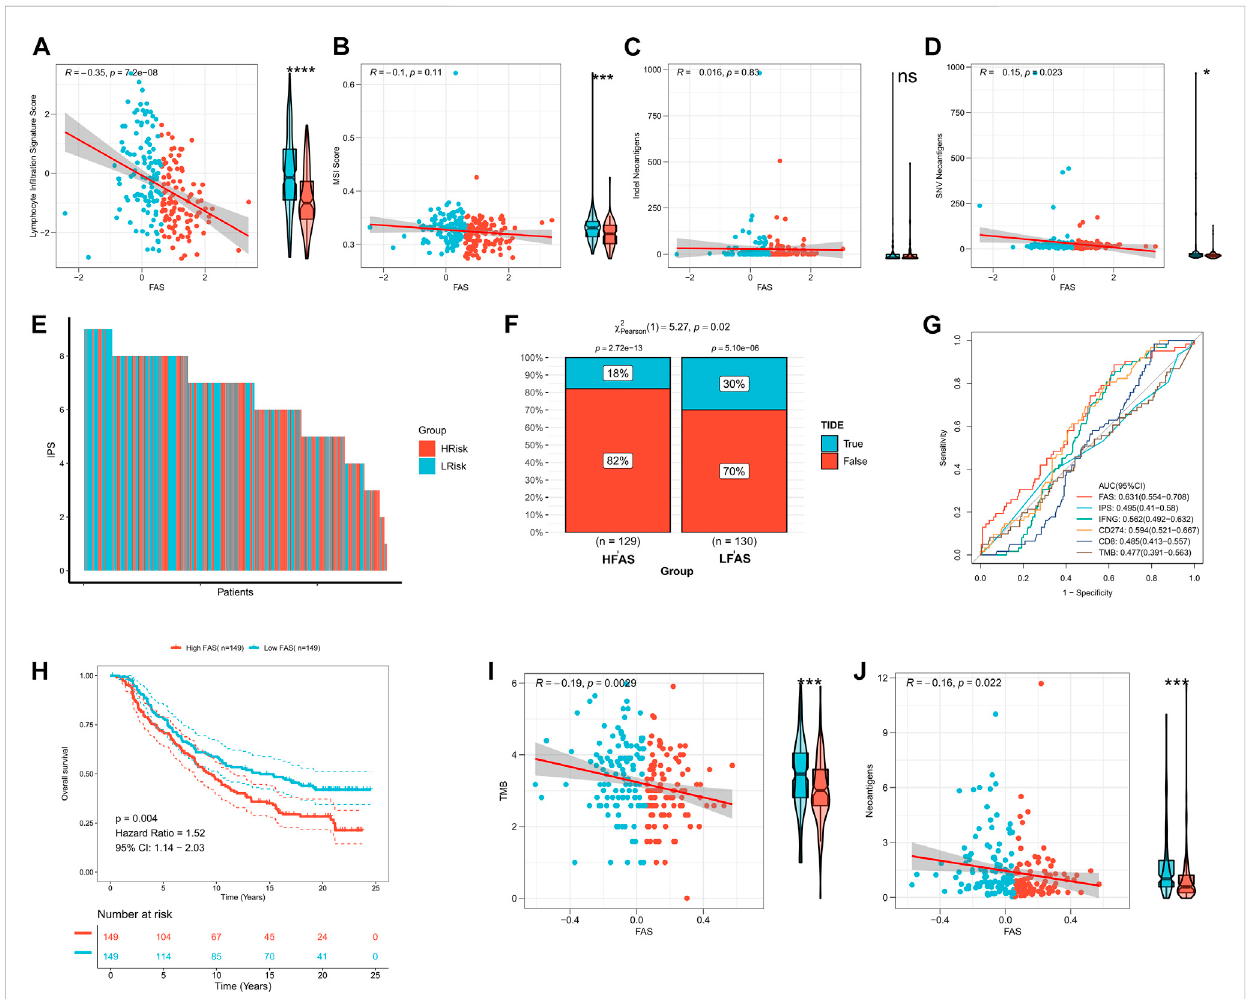
FIGURE 8 The impact of FAS on immunotherapy response in the STS cohort. (A – D) The association of FAS and lymphocyte in fi ltration signature score, MSI score,indelneoantigens,andSNVneoantigens. (E) TheIPSofeachSTSindividual. (F) ThedifferenceinTIDEbetweenthetwodistinctFASgroups. (G) The AUC for immunotherapy response of FAS and other indexes. (H) Kaplan ‒ Meier curves of OS of two FAS groups in the Imvigor210 cohort treated with immunotherapy. (I,J) The correlation of FAS and TMB and